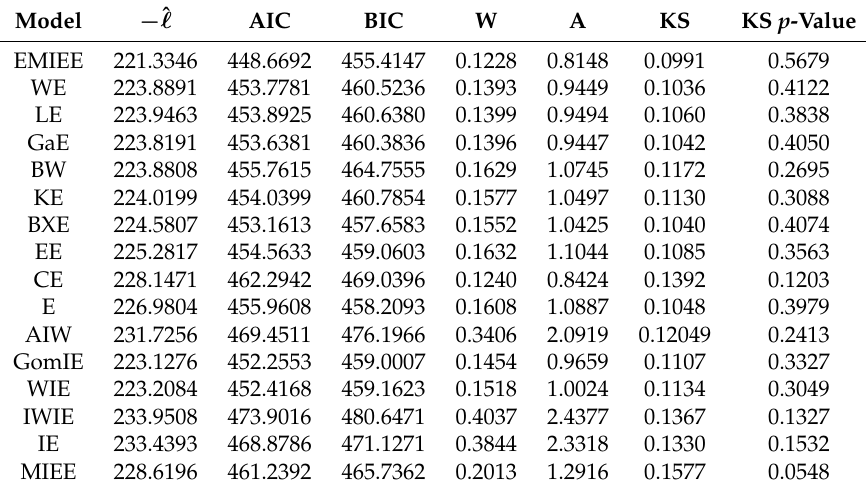
Table 8. Values of − ˆ (cid:96) , AIC, BIC, W, Anderson–Darling (A) criterion, KS, and KS p -value of the 16 considered models for the COVID-19